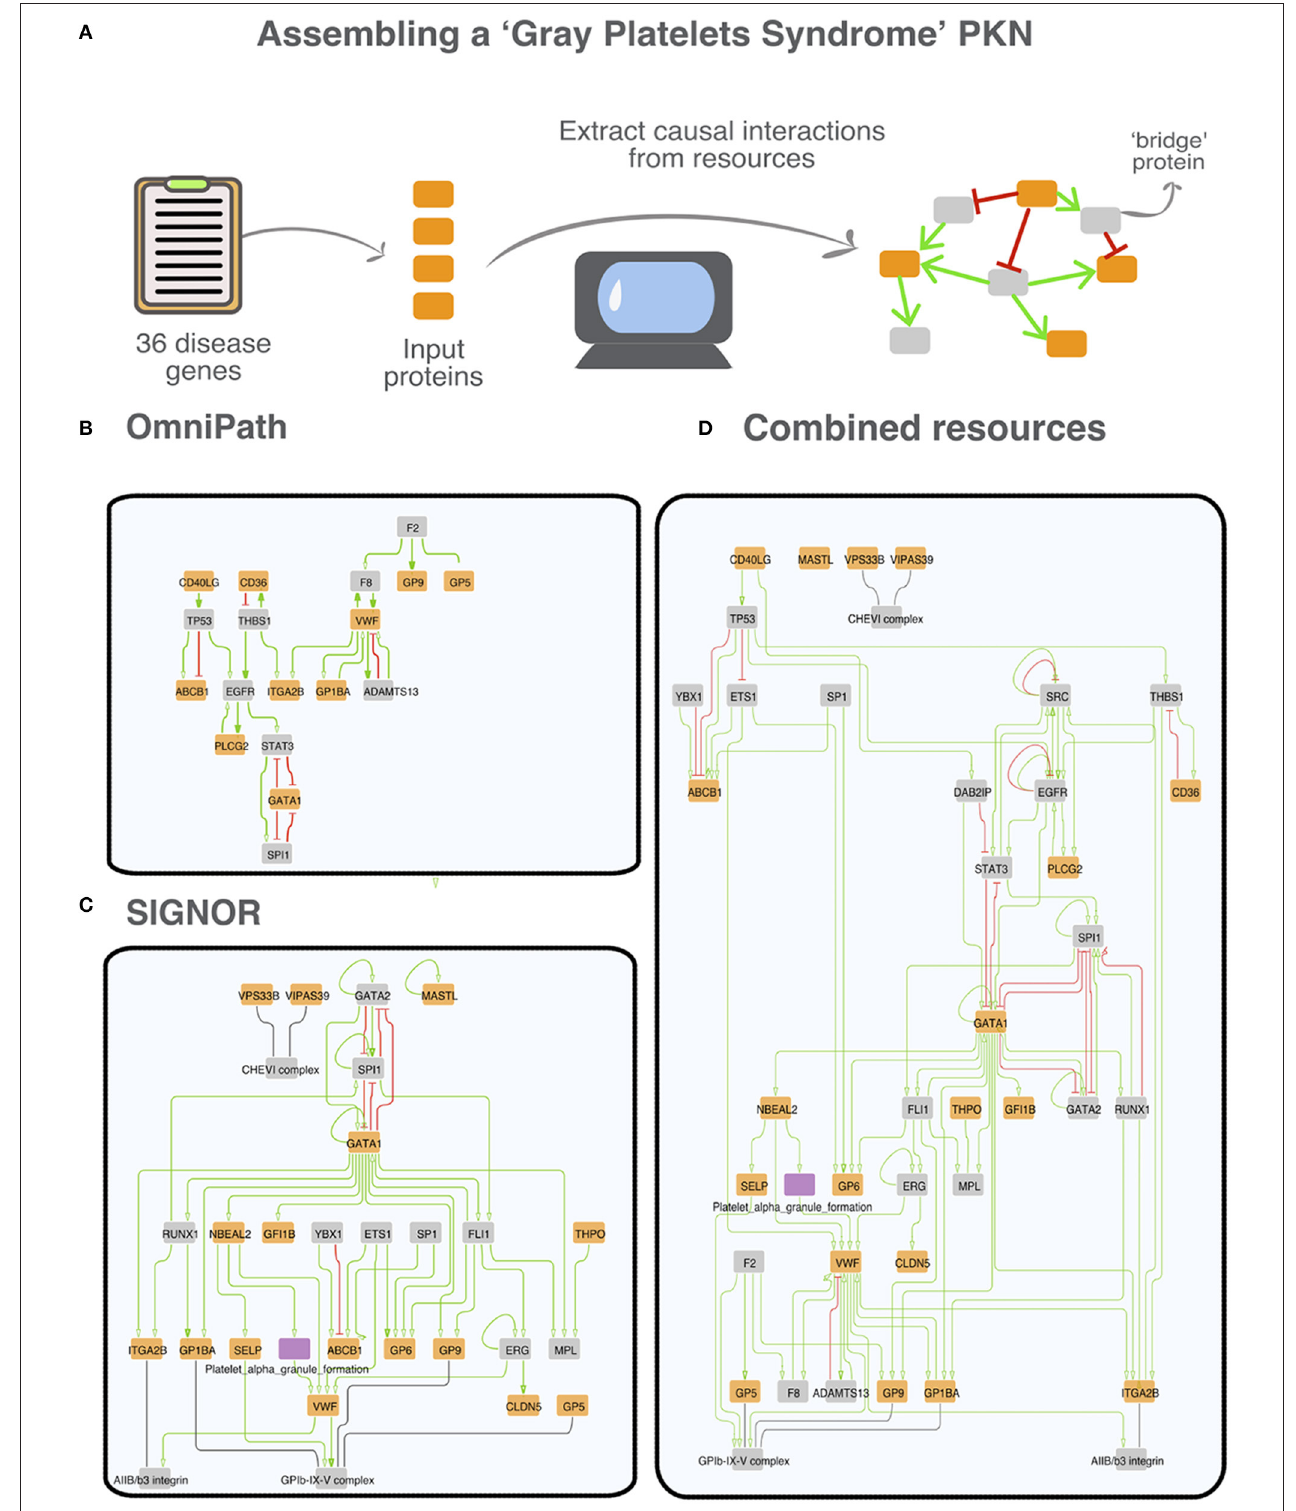
FIGURE 5 | A prior knowledge network (PKN) associated with the “Gray Platelet syndrome.” (A) Strategy to derive the networks from the causal data in each resource. Thirty six gene-disease associations for the Gray Platelet syndrome were downloaded from MalaCards (Rappaport et al., 2017). Disease genes are used